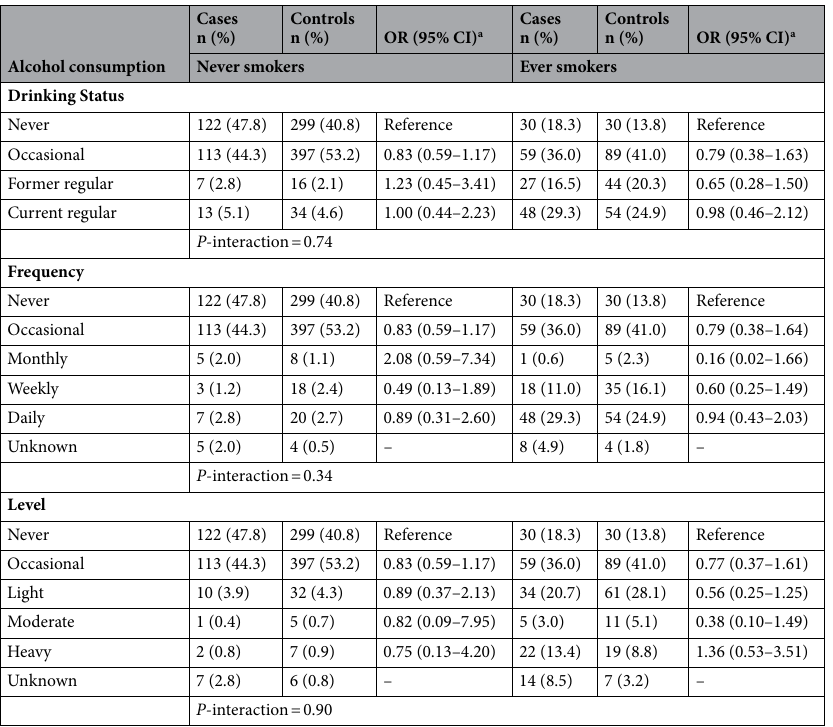
Table 3. The association between alcohol drinking and pancreatic cancer risk stratified by cigarette smoking. CI confidence interval, N number; OR odds ratio. a. OR and 95% CI were calculated using unconditional logistic regression, adjusted for sex, age, education, cigarette smoking (pack-years), oral hygiene score, vegetable consumption, allergy, diabetes/glucose intolerance and BMI at two years before the pancreatic cancer diagnosis for the cases or before the interview date for the controls.